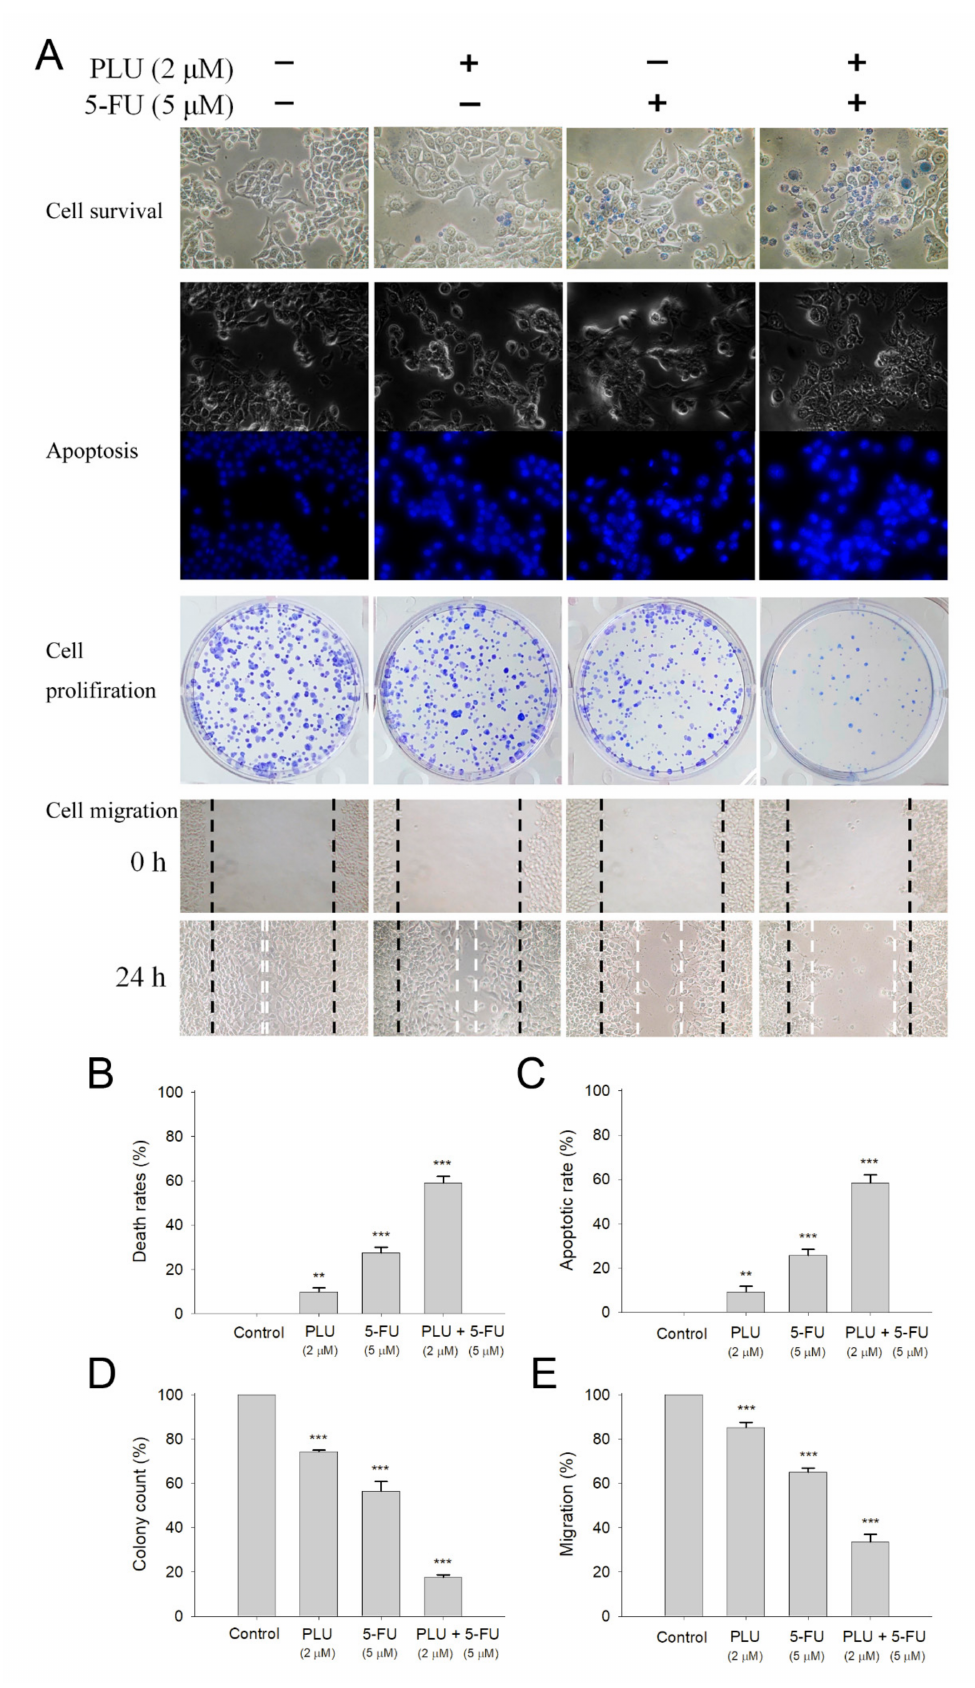
Figure 9. The synergistic anticancer effects of PLU and 5-FU. ( A ) Effects of PLU and 5-FU on